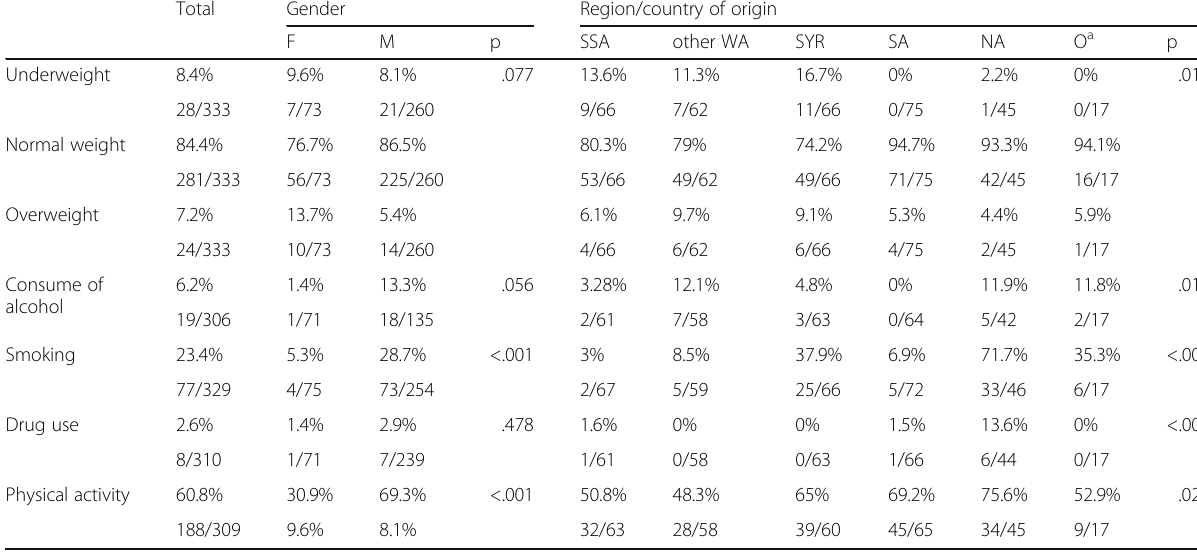
Table 2 Weight status and health (risk) behaviours